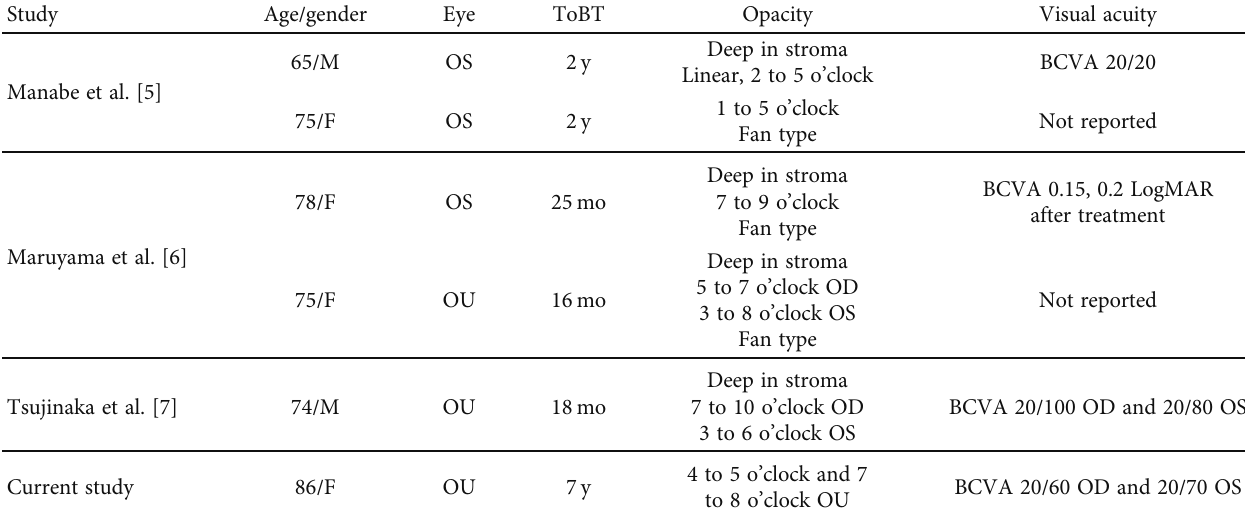
Table 1: Reported cases of LK in the setting of brimonidine